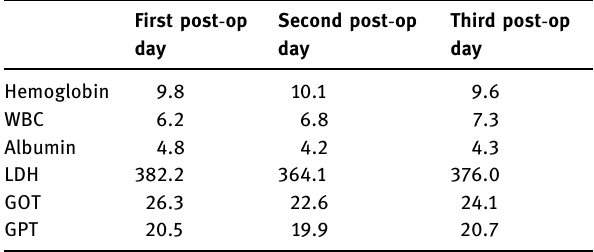
Table 2: Post - operative blood enzymes First post -